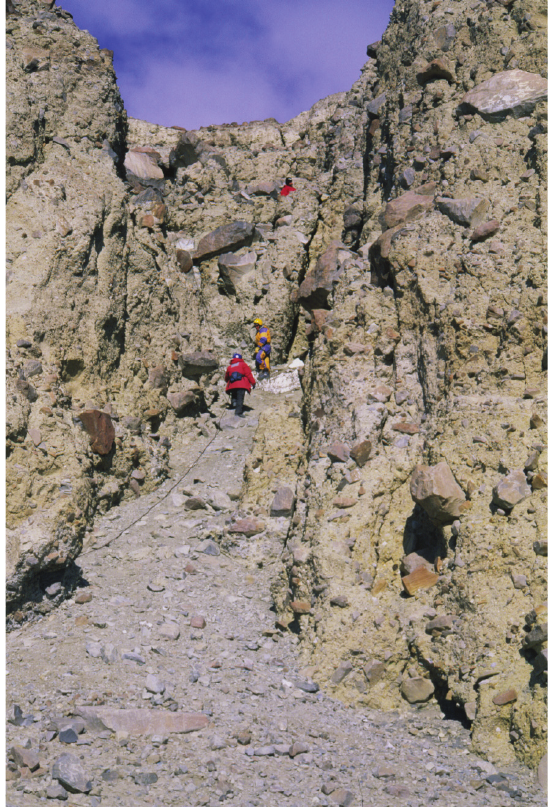
Figure 4. The type locality for A. balli sp. n. is a siltstone lens within a sequence of lodgement tills exposed in the gulley wall to the left of the person highest in the